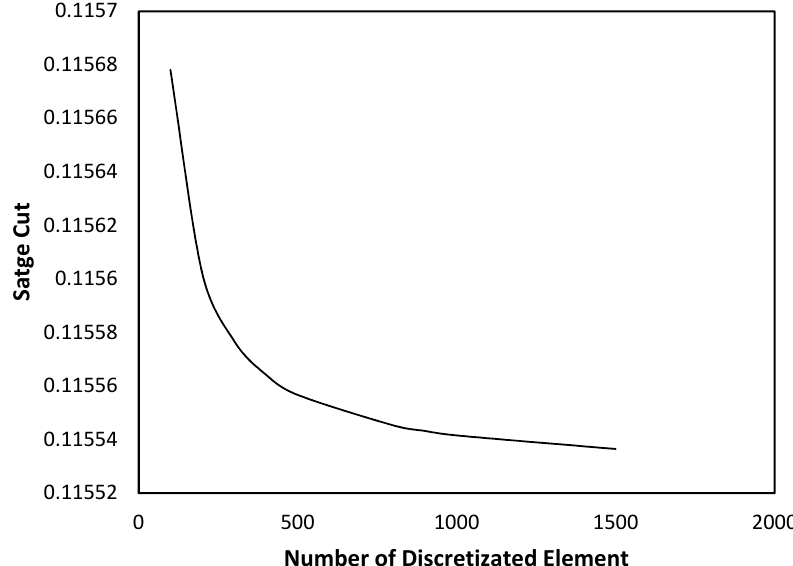
Figure 4. Element sensitivity analysis.